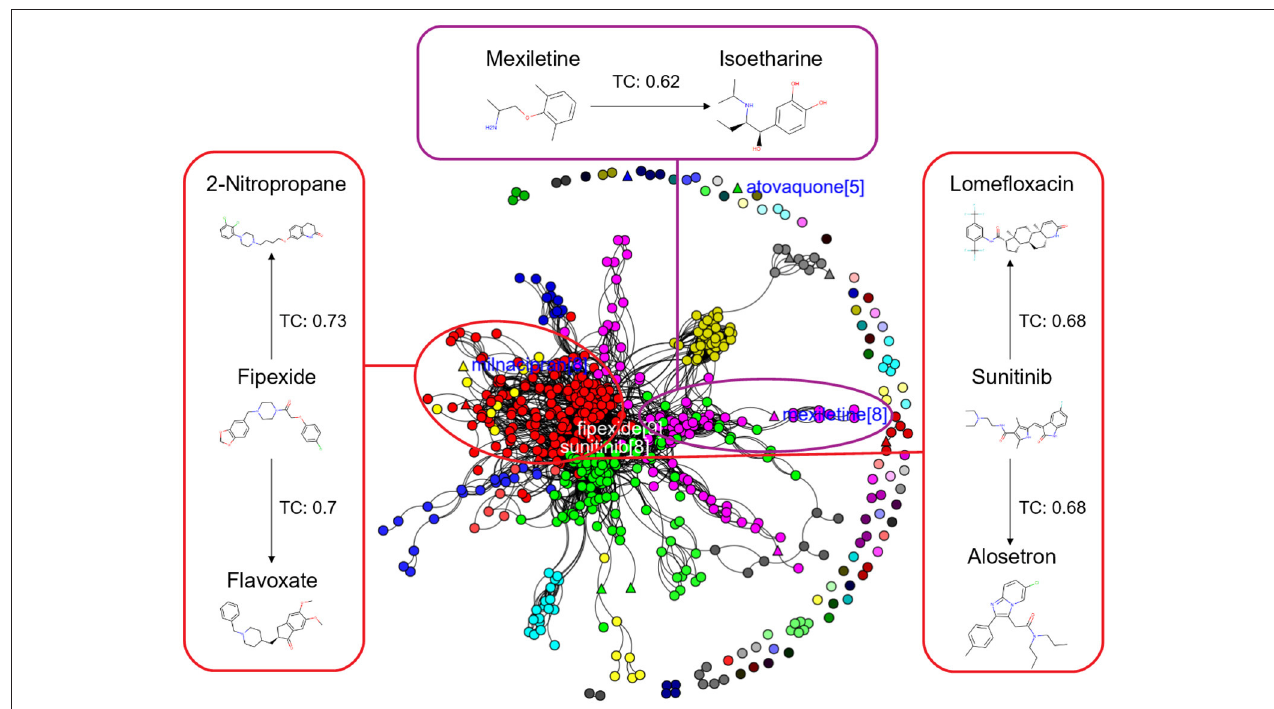
FIGURE 6 | Chemical Space Networks of the actives of external test set (triangle) and inactives of training set (circle). The CSNs reveals that mexiletine (external test active) compound having similarity with isoetharine (training set inactive) is incorrectly predicted by all the sampling methods as inactive (false negative). Similarily fipexide, sunitinib (external set actives) are incorrectly predicted as inactive by all the sampling